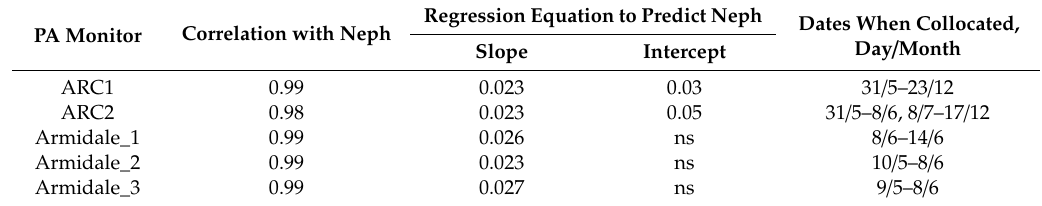
Table2. RelationshipsofhourlyaveragePurpleAir(PA2.5C1 1 )withnephelometer(neph)measurements at the Armidale NSW government pollution